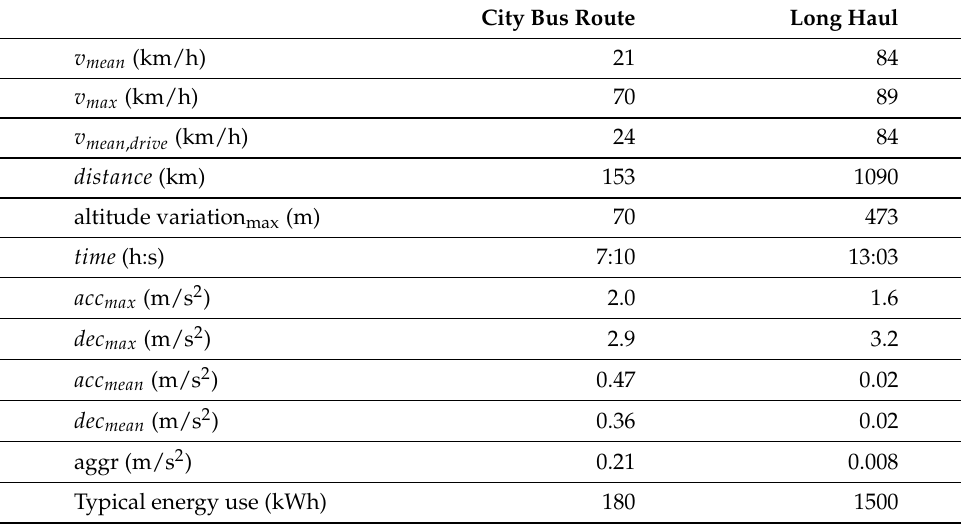
Table 1. The drive cycle in short, three full